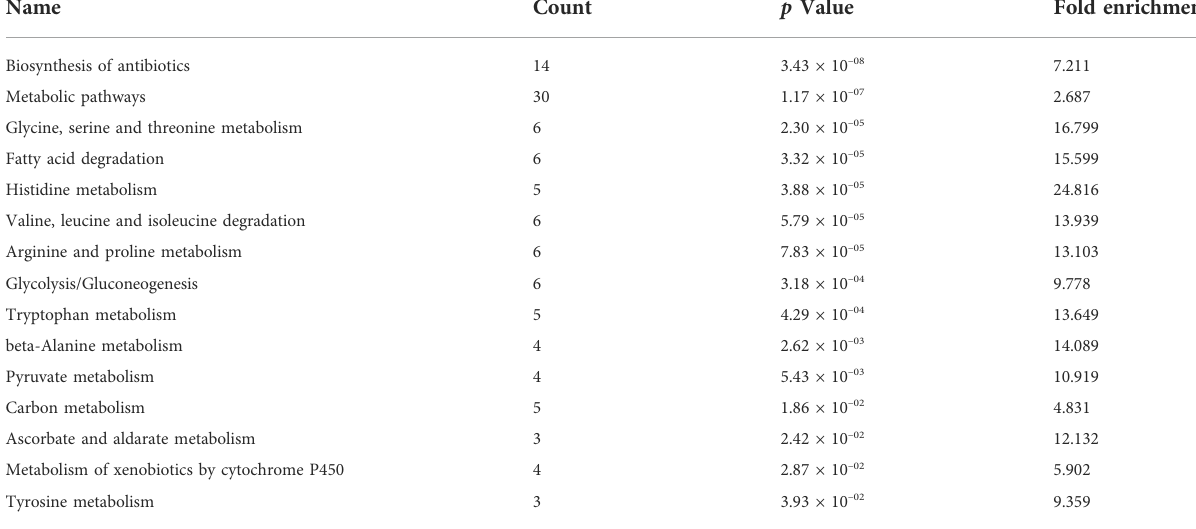
TABLE 1 KEGG pathways enriched by the commonly upregulated proteins in Huh7 cells incubated with sorafenib, lenvatinib and regorafenib at the respective IC 50 for 72